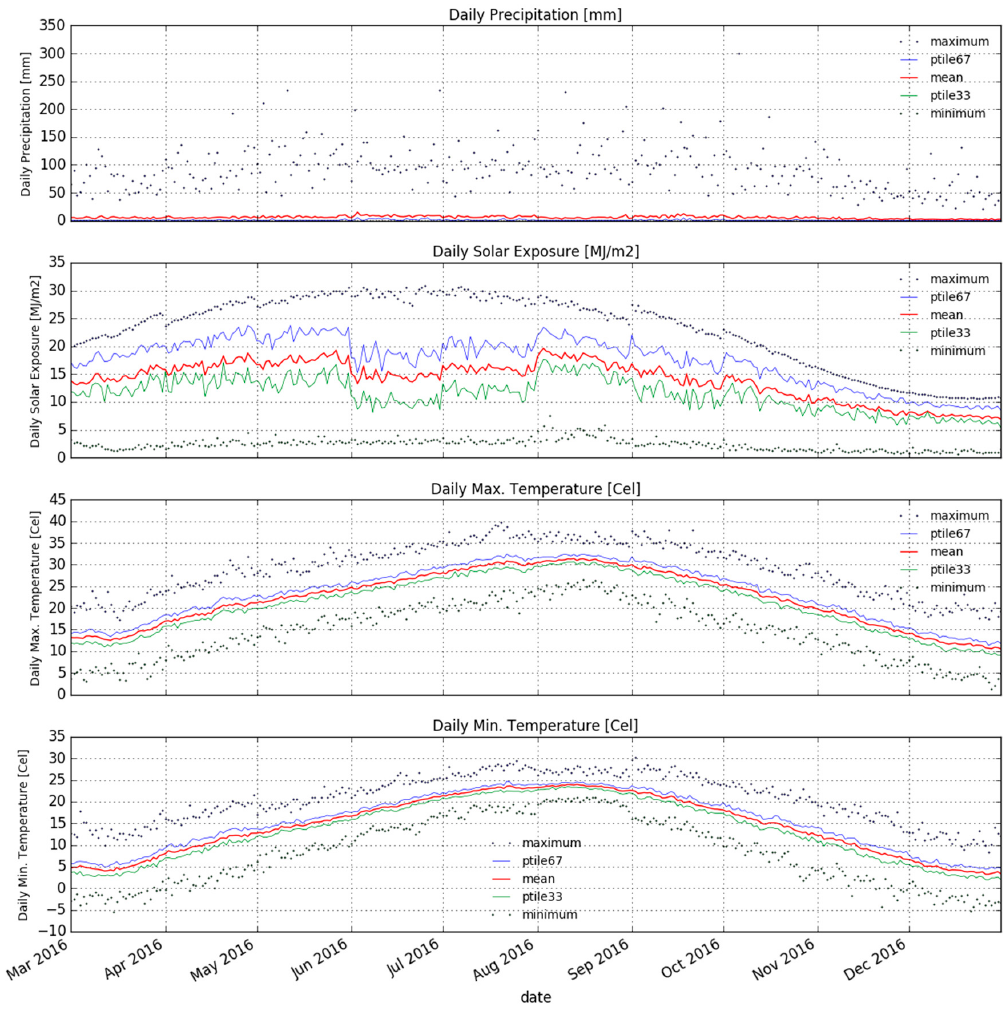
Figure 7. Graph of each climate variable of case study 1 (DISAGWS, normal forecast).